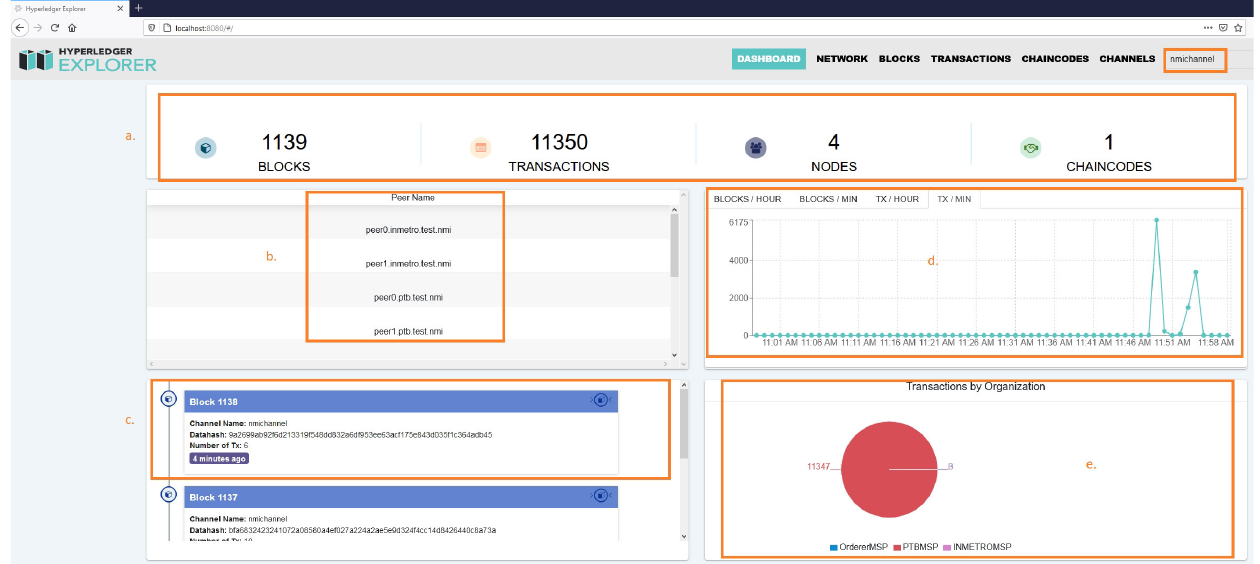
Figure 5. Results of 64 clients/instances in swarm-based network signature